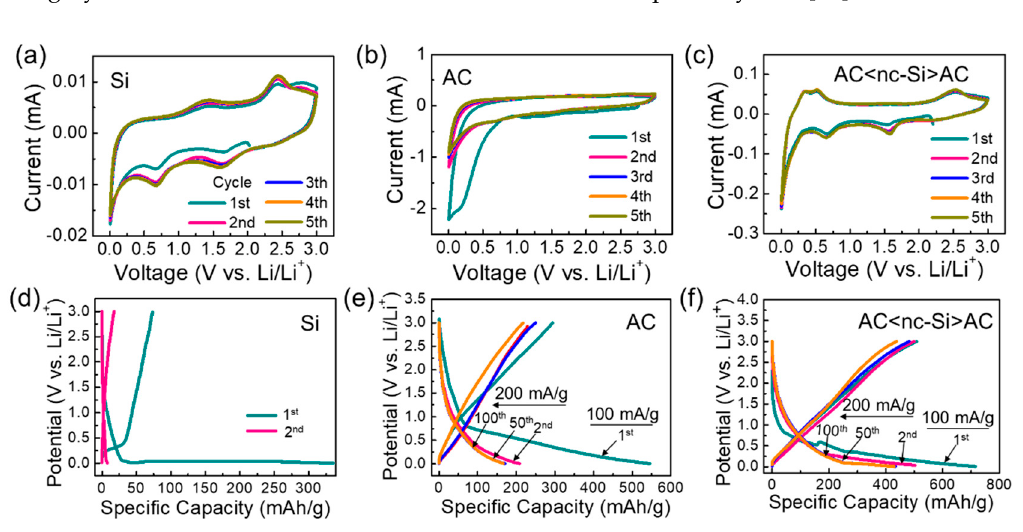
Figure 6. Cyclic voltammetry (CV) curves of the lithium-ion battery (LIB) devices with the ( a ) nc-Si, ( b ) AC, and ( c ) AC<nc-Si>AC nanocomposites as anode materials. All of the CV measurements were conducted under the scanning rate of 0.1 mV/s. Galvanostatic charge–discharge (GCD) curves of the LIB devices with ( d ) nc-Si, ( e ) AC, and ( f ) AC<nc-Si>AC nanocomposites as anode materials. For the first GCD cycle, a current density of 100 mA/g was applied, and the latter cycles were performed at an applied current density of 200 mA/g.